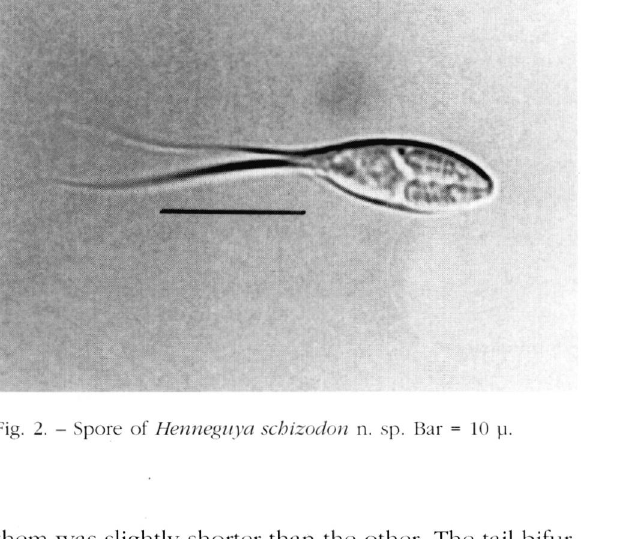
Fig. 2. - Spore of Henneguya schizodon n. sp. Bar = 10µ